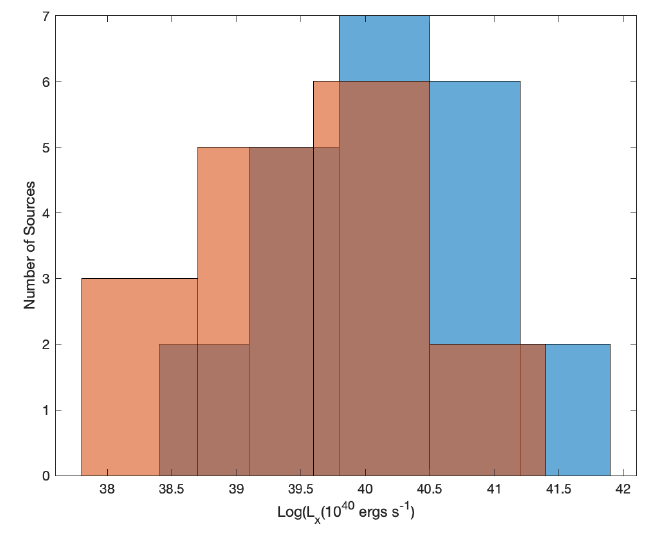
Figure 12. Comparison of IGL core (blue) and disk (orange) sources.